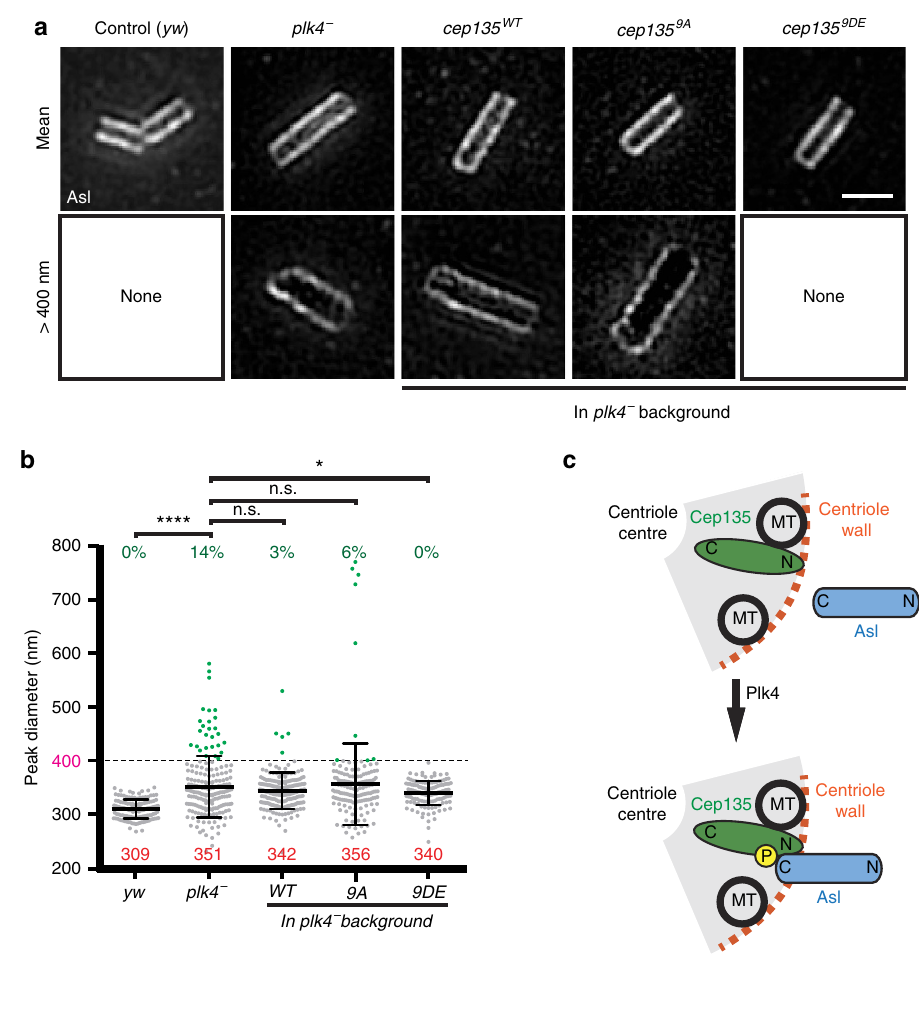
Figure 8 | Plk4 is critical for Asl positioning on centrioles via Cep135 phosphorylation. ( a ) SIM of Asl immunofluorescence in spermatocyte centrioles. Representative centrioles at approximately the mean Asl diameter (top) and with Asl diameter 4 400nm ( 4 5 s.d.’s, bottom) of indicated genotypes; yw and Cep135 FL-9DE (in plk4 background) show no centrioles 4 400nm. ( b ) plk4 mutant centrioles show great expansion of Asl peak diameter, which is partially rescued by Cep135 FL-9DE . Bars indicate the mean (red numbers) ± s.d.; Ns are centrioles— yw ¼ 138 (same data as in Fig. 7b), plk4 (cid:2) ¼